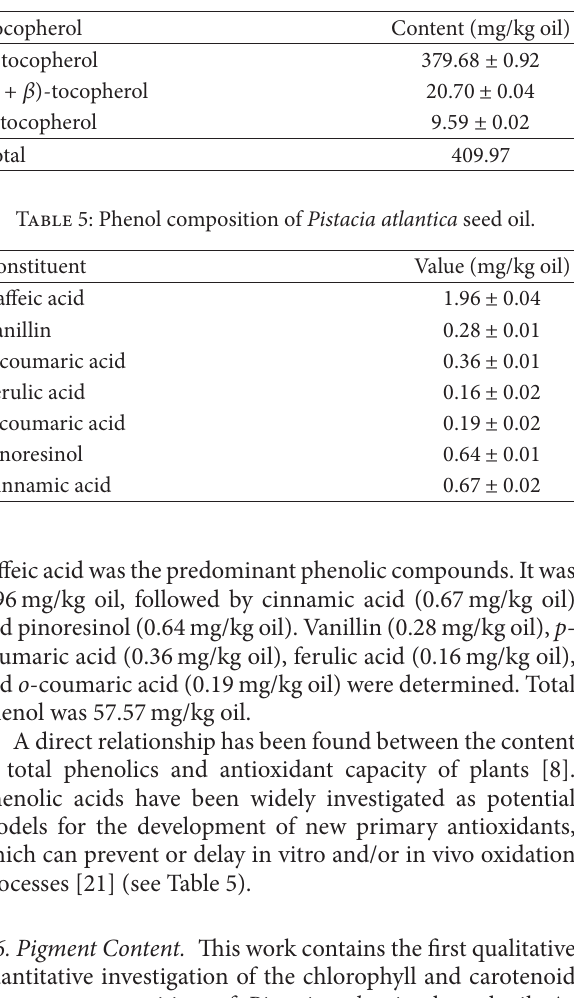
T 4: Tocopherol composition of Pistacia atlantica seed